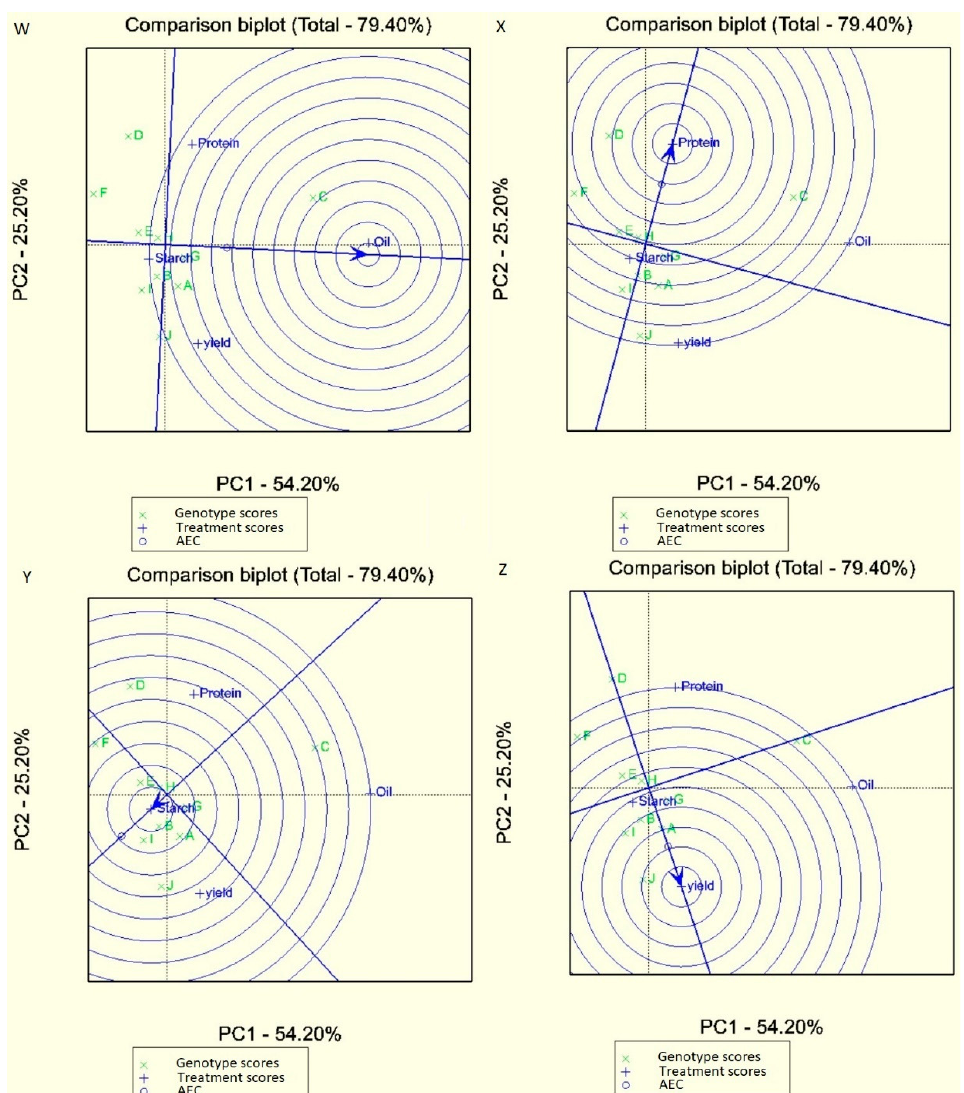
Figure 5. GGE biplot hybrids in N fertilizers ( W ): oil content, ( X ): protein content, ( Y ): Starch content, ( Z ): Grain yield; A (FAO300), B (FAO330), C (FAO340), D (FAO350), E (FAO380), F (FAO360), G (FAO420), H (FAO490), I (FAO370), J (FAO430); Yield (grain yield), Starch (starch content), Protein (protein content), Oil (oil content).